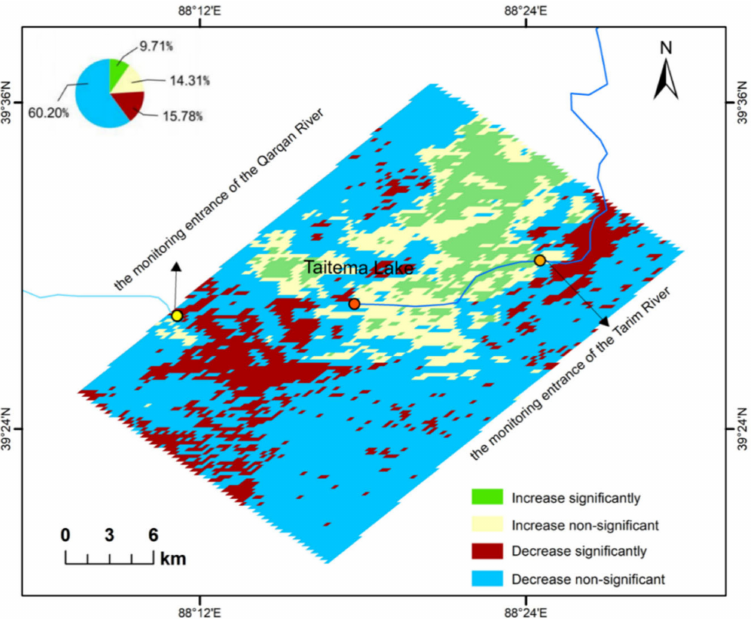
Figure 5. Spatial variation trend of fractional vegetation cover of the Taitema lake region from 2000 to